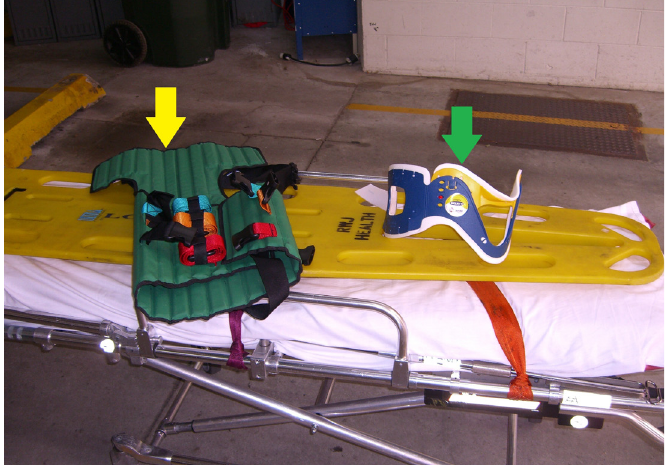
Figure 1. Application of Kendrick Extrication Device (yellow arrow) or cervical collar (green arrow).